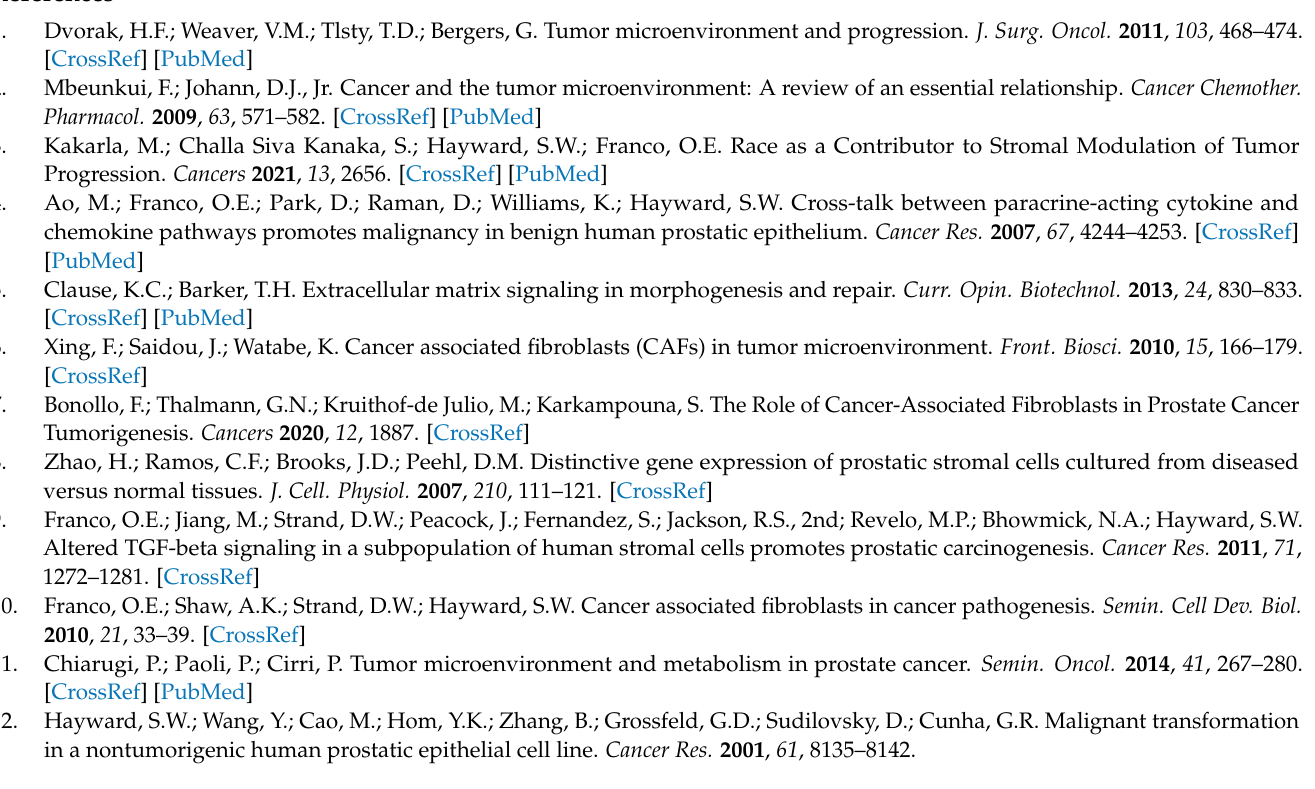
Figure S9: Uncropped Western blots corresponding to Figure 2b; Figure S10: Uncropped Western blots corresponding to Figure 6c; Figure S11: Uncropped Western blots corresponding to Figure S5a; Figure S12: Uncropped Western blots corresponding to Figure